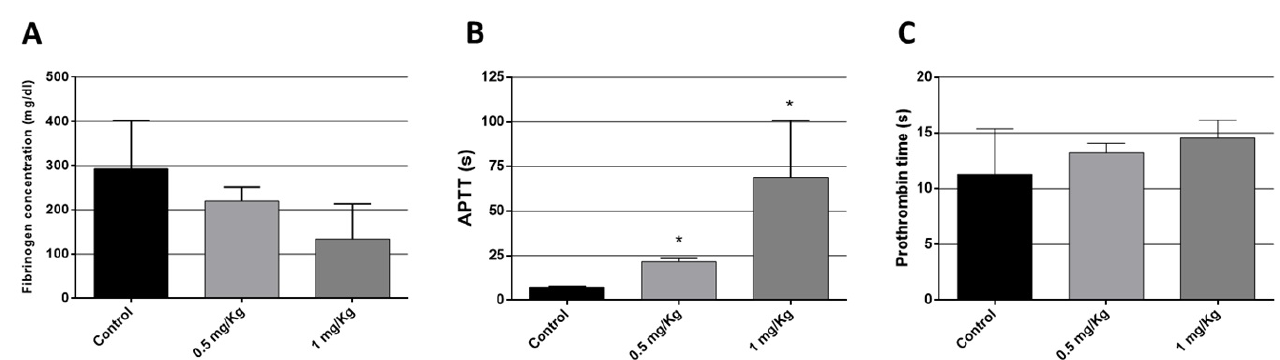
Figure 4. Effect of rCollinein-1 on coagulation parameters . For analysis of blood coagulation parameters, male Swiss mice (18 – 22 g) groups (n=4) were inoculated intraperitoneally with different doses of rCollinein-1. Animals inoculated with PBS were used as control. After 3 hours, the animals were euthanized and the blood was collected by cardiac puncture, using sodium citrate as anticoagulant (50 μL/mL). The collected blood was centrifuged, and the plasma was used to determine the concentration of fibrinogen (a) , activated partial thromboplastin times (b) and prothrombin time (c). * p < 0.05 compared to the negative control.